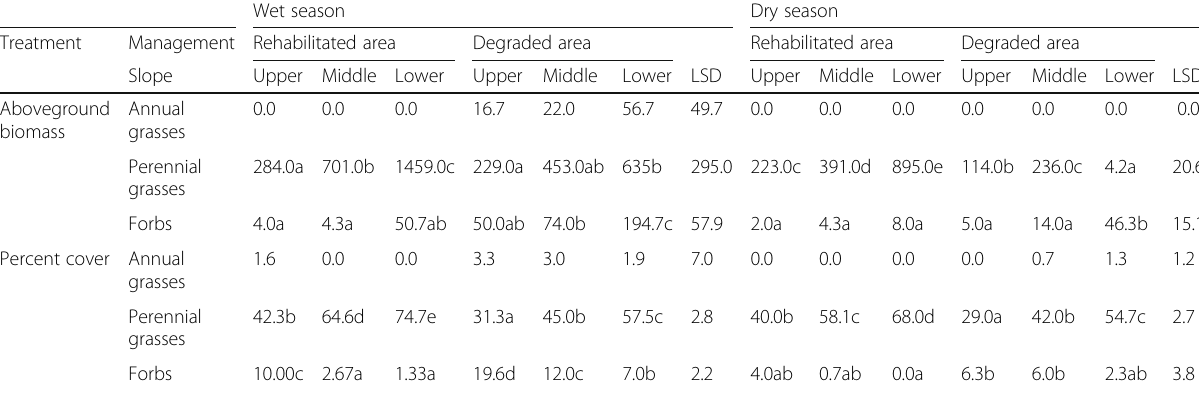
Table 2 Aboveground herbaceous biomass (kg/ha) and percent cover (%) in rehabilitated and degraded areas of Suswa catchment during wet and dry